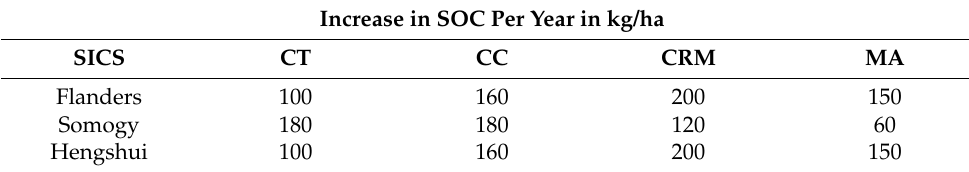
Table 3. Increase in SOC per year in kg/ha for four SICS